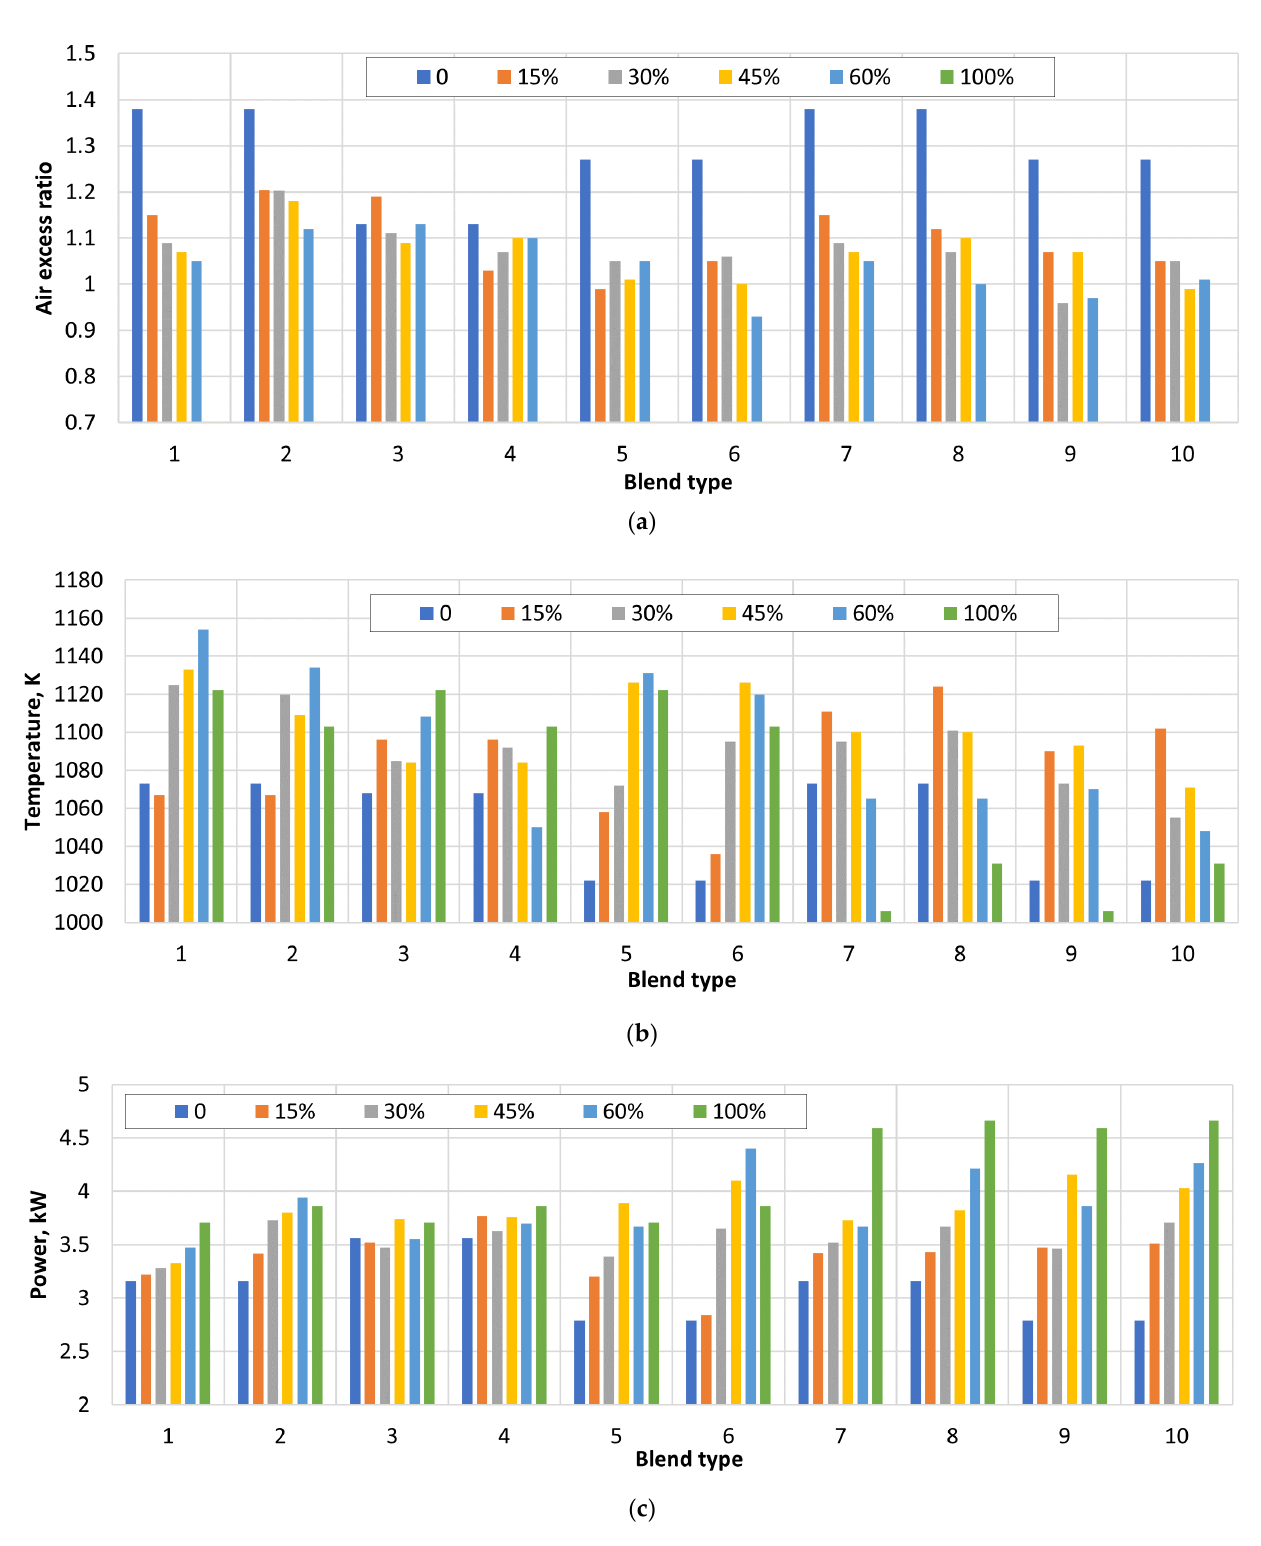
Figure 10. The air excess ratio at flame base ( a ), temperature in a reaction zone (L/D = 3) ( b ), and heat power of the device ( c ) for the different types of selectively MW pre-treated blends (for composition of blends see Figure 4).